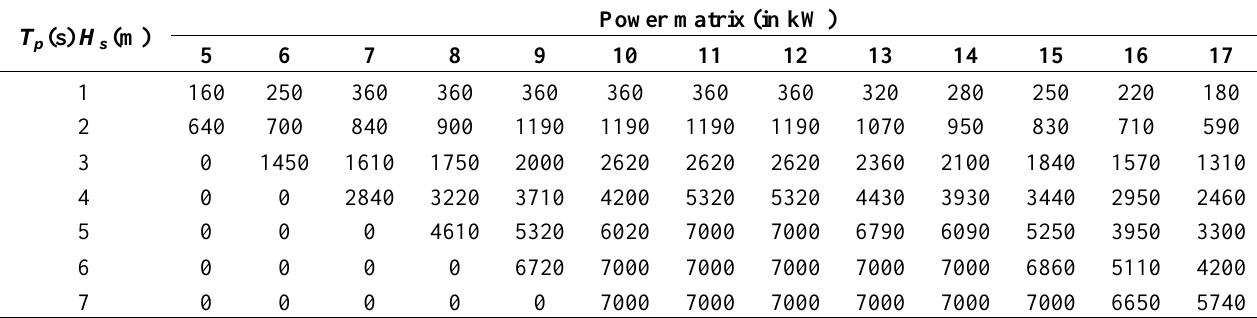
Table A4. Power matrix (in kW) for the wave energy converter Wave